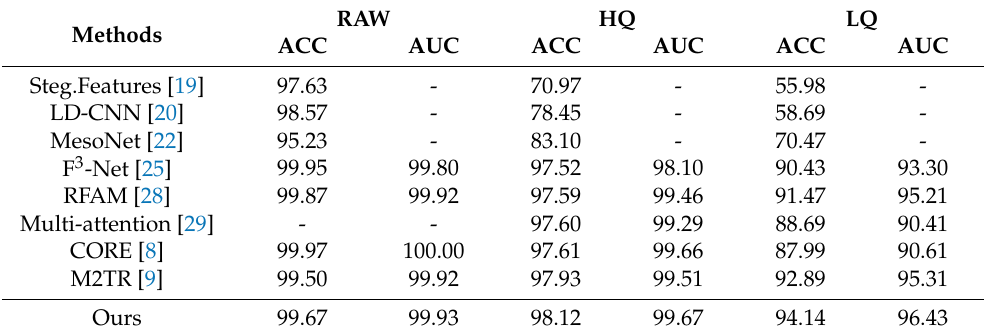
Table 2. Detection results of Acc and AUC at frame level for our method and the state-of-the-art (FF++). Methods